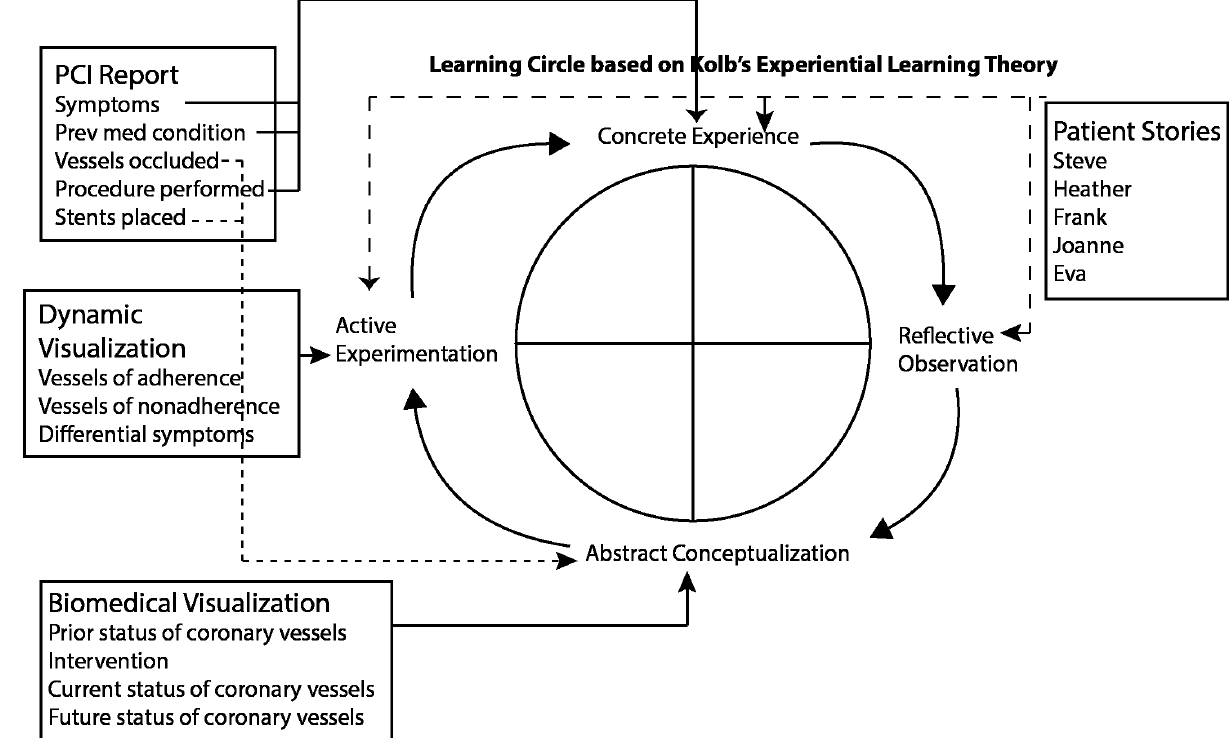
Figure 4. Conceptual framework for the My Interventional Drug-Eluting Stent Educational App. Integration of the multiple aspects of the project with Kolb’s experiential learning theory. The patient will start at the concrete experience of the symptoms of the disease and patient stories. The patient will then reflect on the patient stories. The biomedical visualization pulls in information from the percutaneous coronary intervention report and provides the learning content (abstract conceptualization). Finally, the active experimentation allows the patient to see the potential outcomes of failure to adhere to the suggested medication regimen.